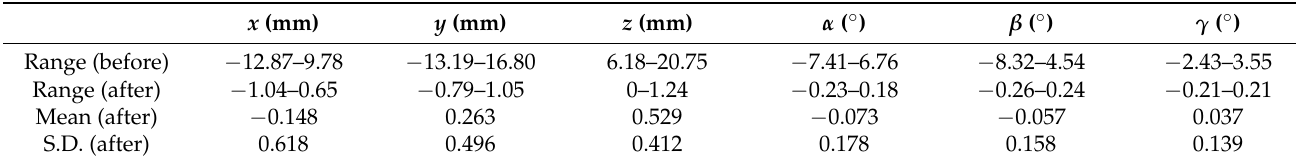
Table 2. Relative pose of the model before and after